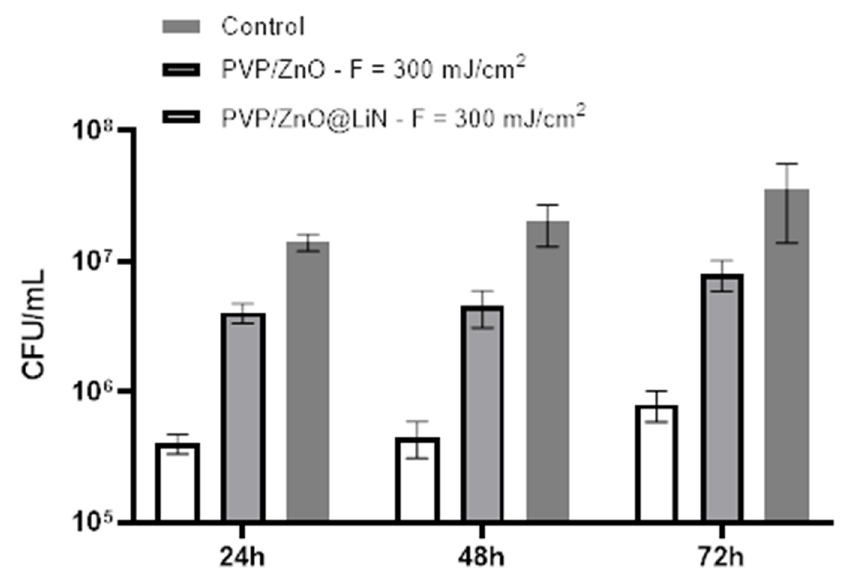
Figure 20. Evaluation of microbial biofilm development at 24, 48, and 72 h after incubation with S. aureus in the presence and absence of PVP/ZnO@LiN